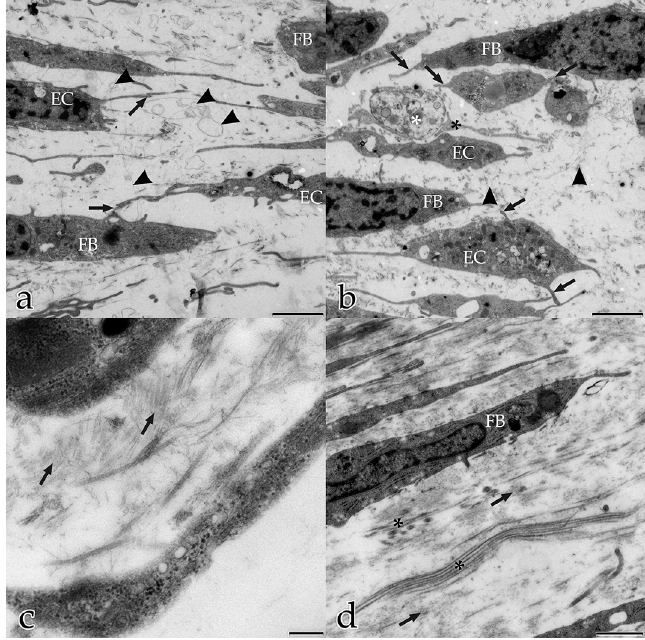
Figure 5. Coculture of ECs with FBs after 5 days ( a , b ), and after 20 days ( c , d ). In ( a , b ) FBs and ECs are interconnected with each other by their long filopodial processes (arrows). Fine ECM fibrils form a network between the cells (arrowheads). Extracellular vesicles (white asterisk) located within the ECM. Cellular filopodia contact the extracellular vesicles; ( c , d ) ECM with a close resemblance to a histological section of loose connective tissue in situ. Densely organized and well-differentiated meshwork of collagen bundles (asterisks), fibers, and fibrils (arrows). Thick collagenous bundles